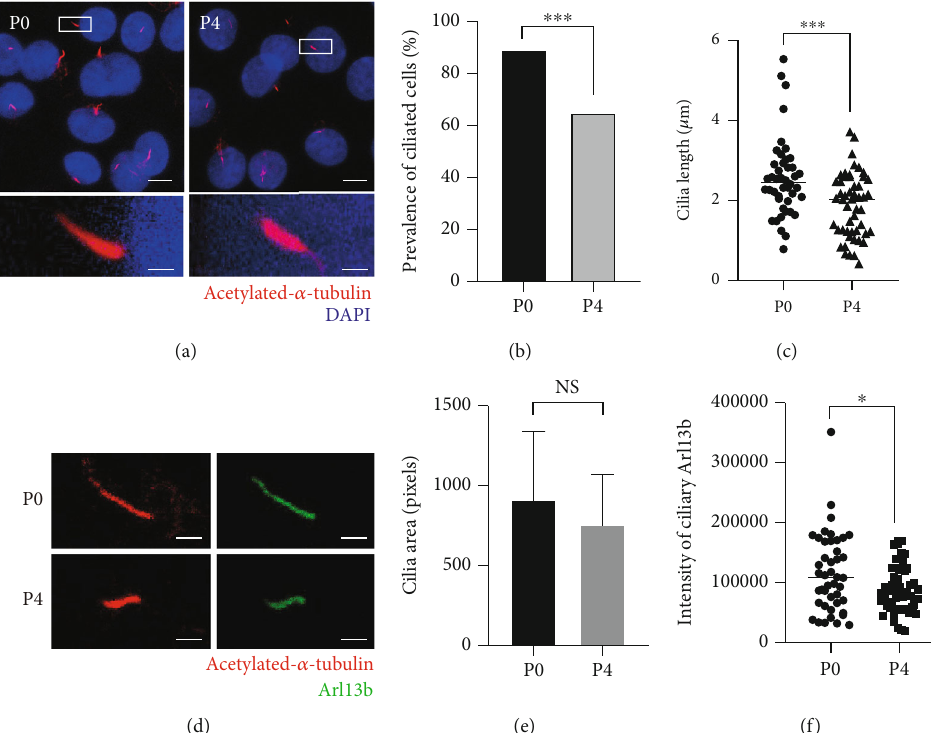
Figure 3: Expansion caused reductions in the number and length of primary cilia and Arl13b staining intensity on cilia in MSCs. Serum starvation was performed before primary cilia staining. P0 and P4 MSCs cultured on coverslips were analyzed by capturing confocal images of primary cilia. (a) Representative confocal microscopy maximum intensity projection images of MSCs labeled with acetylated α - tubulin (red) and DAPI (blue). The number of cilia (b) and cilia length (c) was determined. (d) Representative maximum intensity projection images of primary cilia immuno fl uorescence labeled with acetylated- α -tubulin (red) and Arl13b (green). The changes in the cilia area (e) and Arl13b staining intensity on cilia (f) are shown. The Mann – Whitney test. ∗ p < 0 : 05 versus the corresponding P0